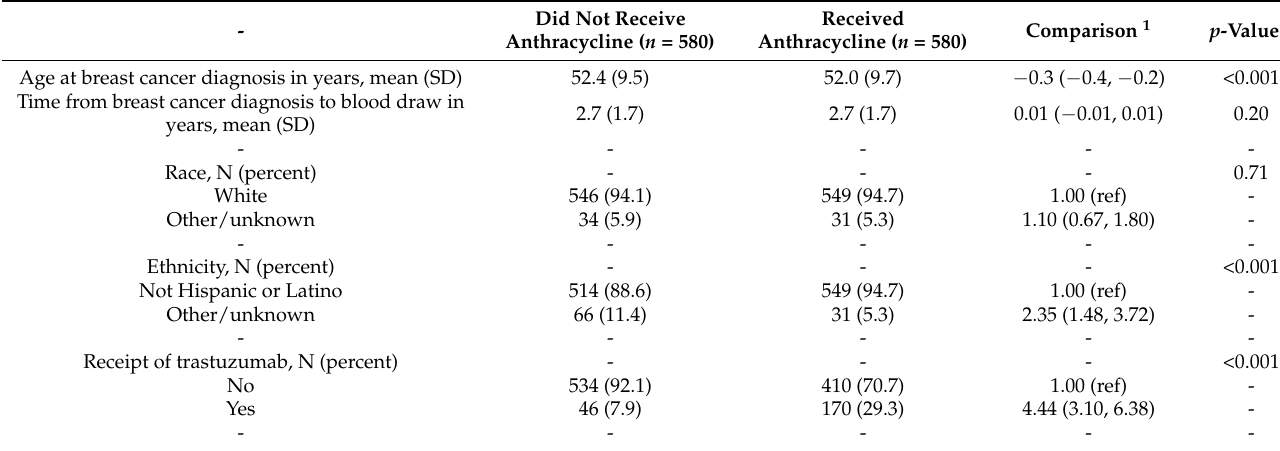
Table 1. Comparison of demographic and clinical variables with receipt of anthracycline.